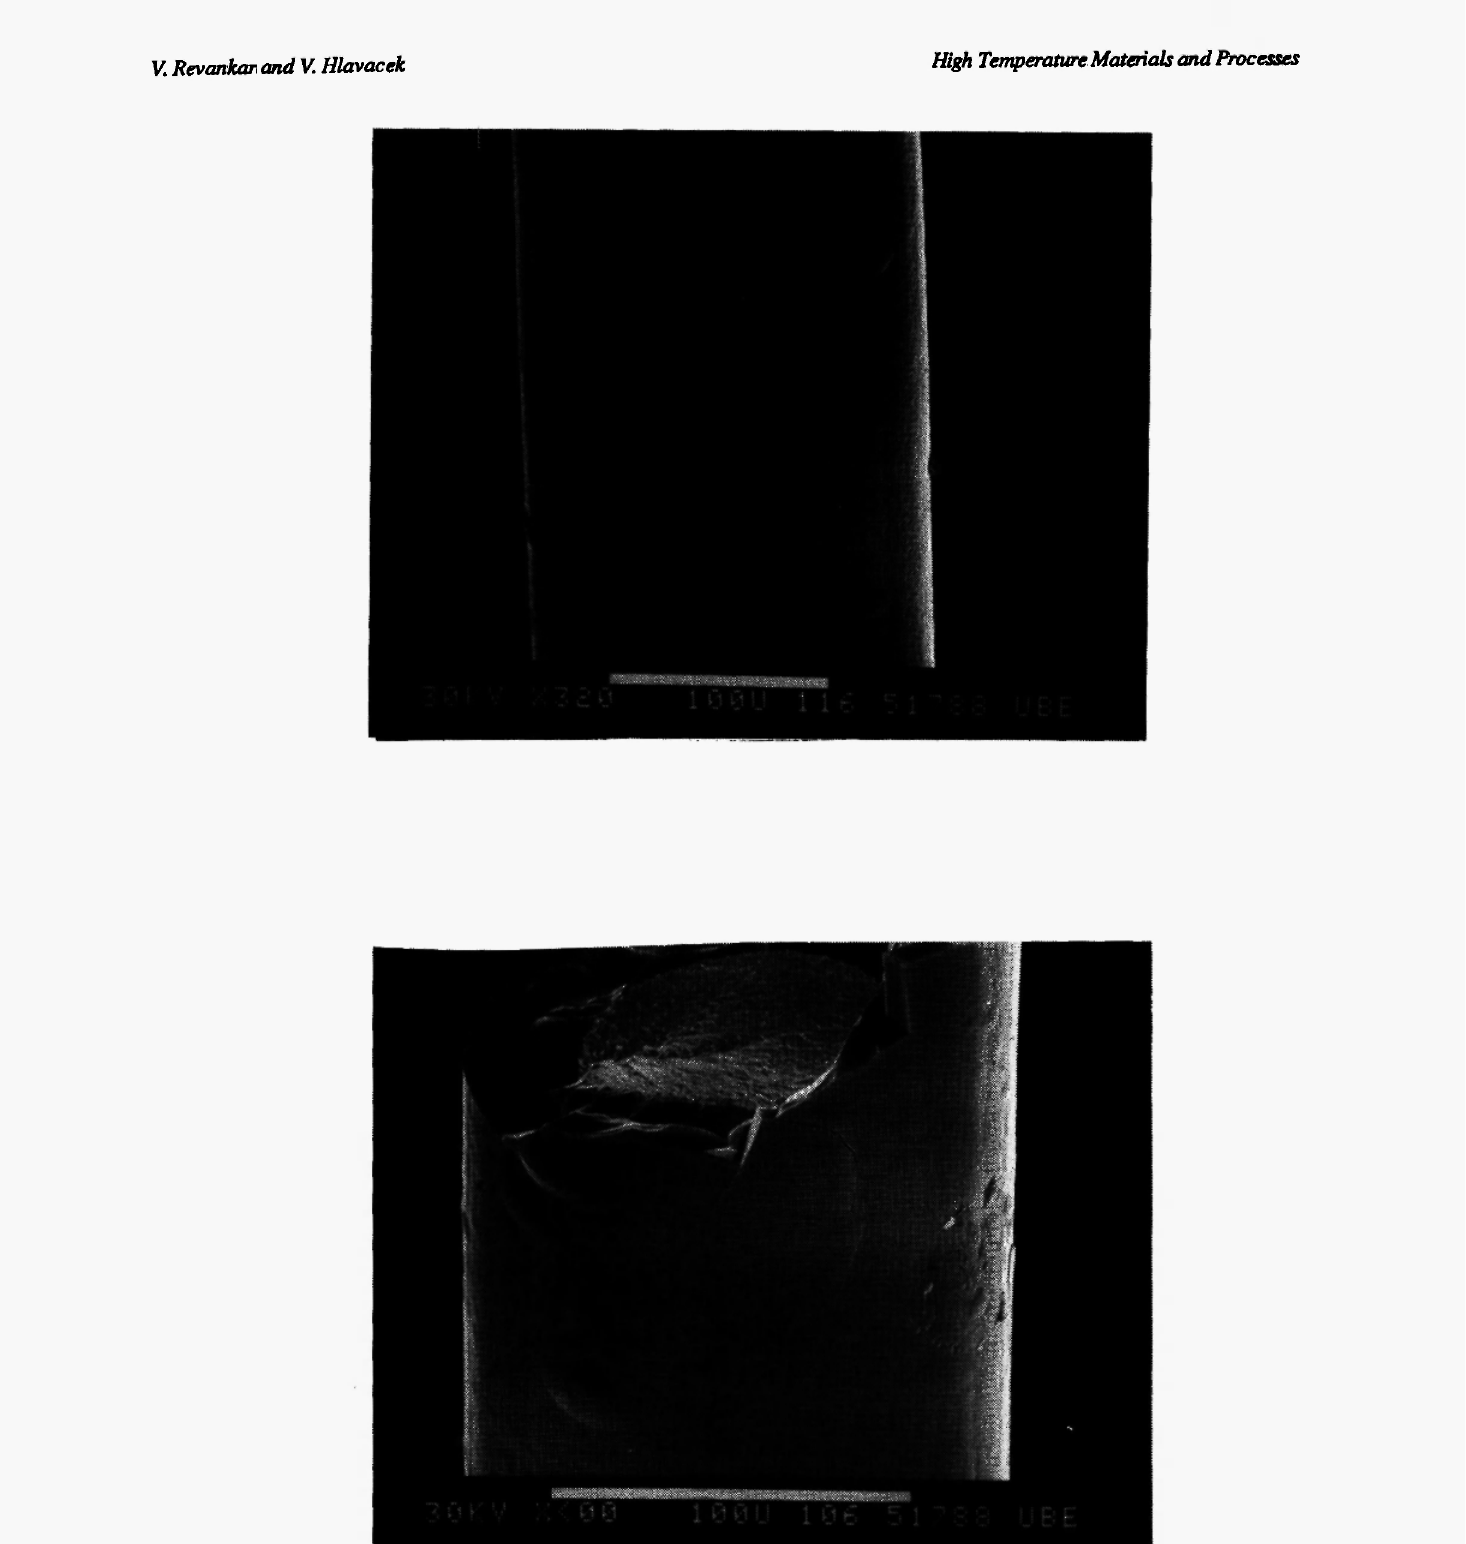
Fig. 10: B 4 C fibers, (a) Deposition on tungsten core at 1400°C with B:C=2 and H :CI = 2. (b) At the previous conditions but with CH^ as carbon